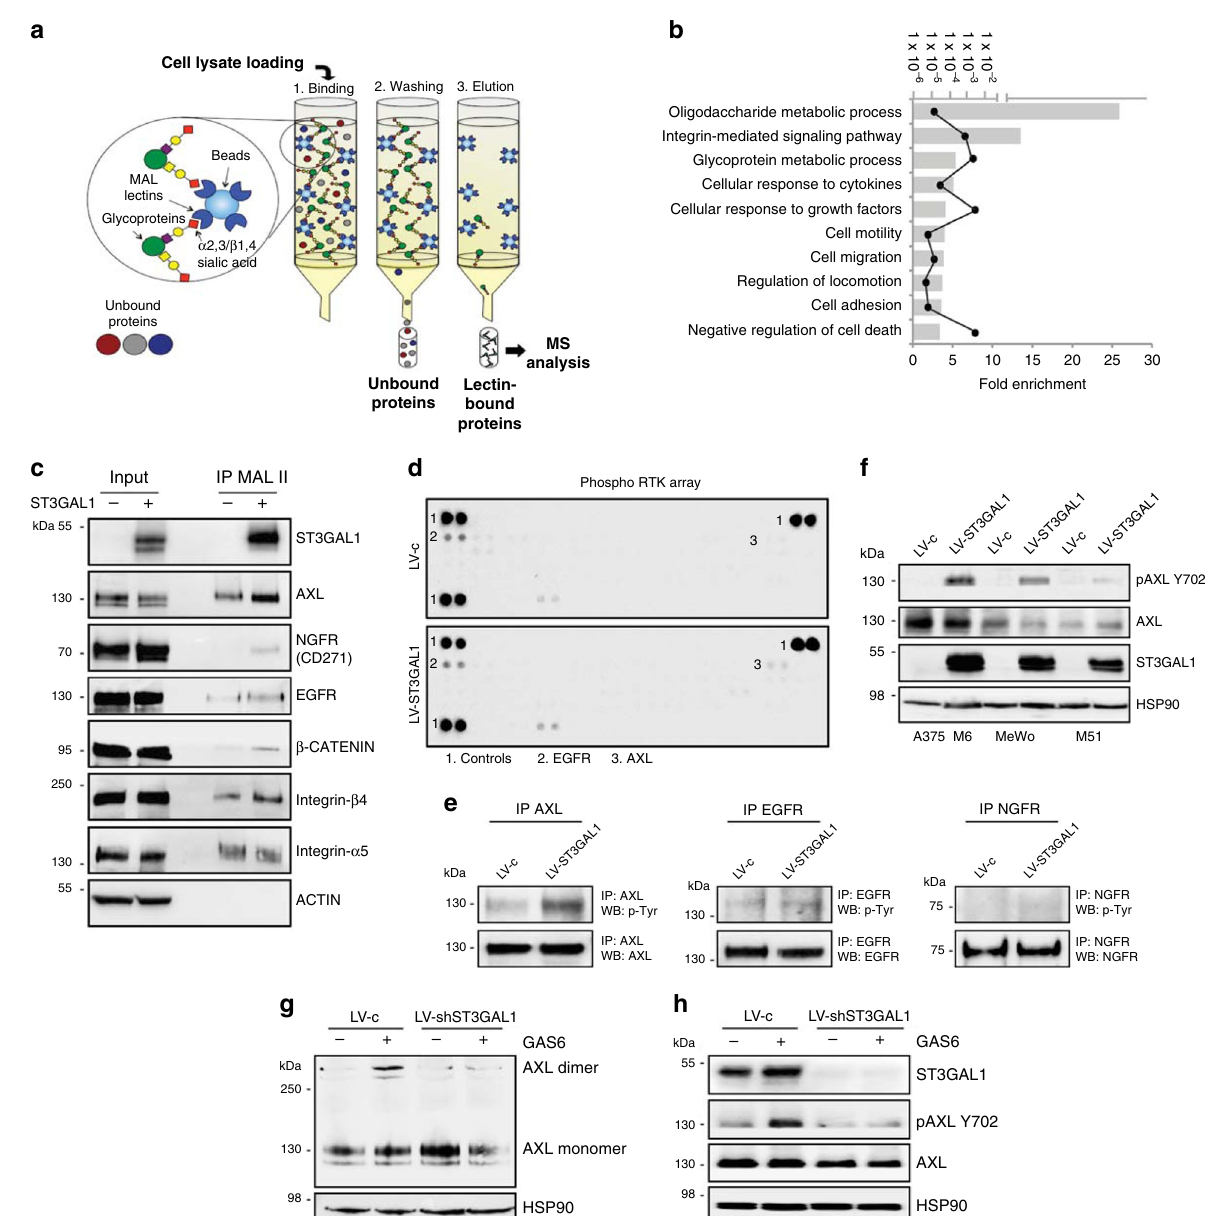
Fig. 7 Identi fi cation of AXL as a ST3GAL1 substrate in melanoma cells. a Schematic illustration of the experimental approach showing af fi nity enrichment of sialylated proteins by MAL lectin af fi nity chromatography in A375 M6 cells. b Gene ontology enrichment analysis (category of biological processes) of sialylated proteins in LV-ST3GAL1 versus LV-shST3GAL1.1 A375 M6 cells. Black line indicates p values. See also Supplementary Data 2 and Supplementary Table 2. c MAL-II lectin af fi nity immunoprecipitation (IP) of whole-cell lysates of A375 M6 transduced with LV-ST3GAL1 ( + ) or LV-shST3GAL1.1 ( − ), followed by western blot of ST3GAL1, AXL, NGFR, EGFR, β -Catenin, Integrin β 4, or Integrin α 5. ACTIN was used as loading control. Input was 5% of the total IP. d Representative phospho-receptor tyrosine kinase (RTK) assay in A375 M6 melanoma cells transduced with LV-c or LV-ST3GAL1. Numbers indicate loading controls 1 and activated RTKs 2,3 ( n = 2 biological independent experiments). e Western blot of phospho-Tyrosine after immunoprecipitation with AXL, EGFR, or NGFR in A375 M6 cells transduced with LV-c or LV-ST3GAL1. f Western blot of pAXL-Y702, AXL, and ST3GAL1 in A375 M6, MeWo, and M51 cells transduced as indicated. HSP90 was used as loading control. g Dimerization of AXL in A375 M6 cells transduced with LV-c or LV-shST3GAL1, stimulated with Gas6 (250 ng/ml) for 1 h and crosslinked with BS3. Both AXL monomer and dimer were visible in the immunoblot. HSP90 was used as loading control. h Western blot of pAXL-Y702, AXL, and ST3GAL1 in A375 M6 transduced with LV-c or LV-shST3GAL1 upon Gas6 stimulation (250 ng/ml) for 1 h. HSP90 was used as loading control. Blots in c and e – h are representative of n = 3 biological independent experiments. Source data are provided as Source Data fi